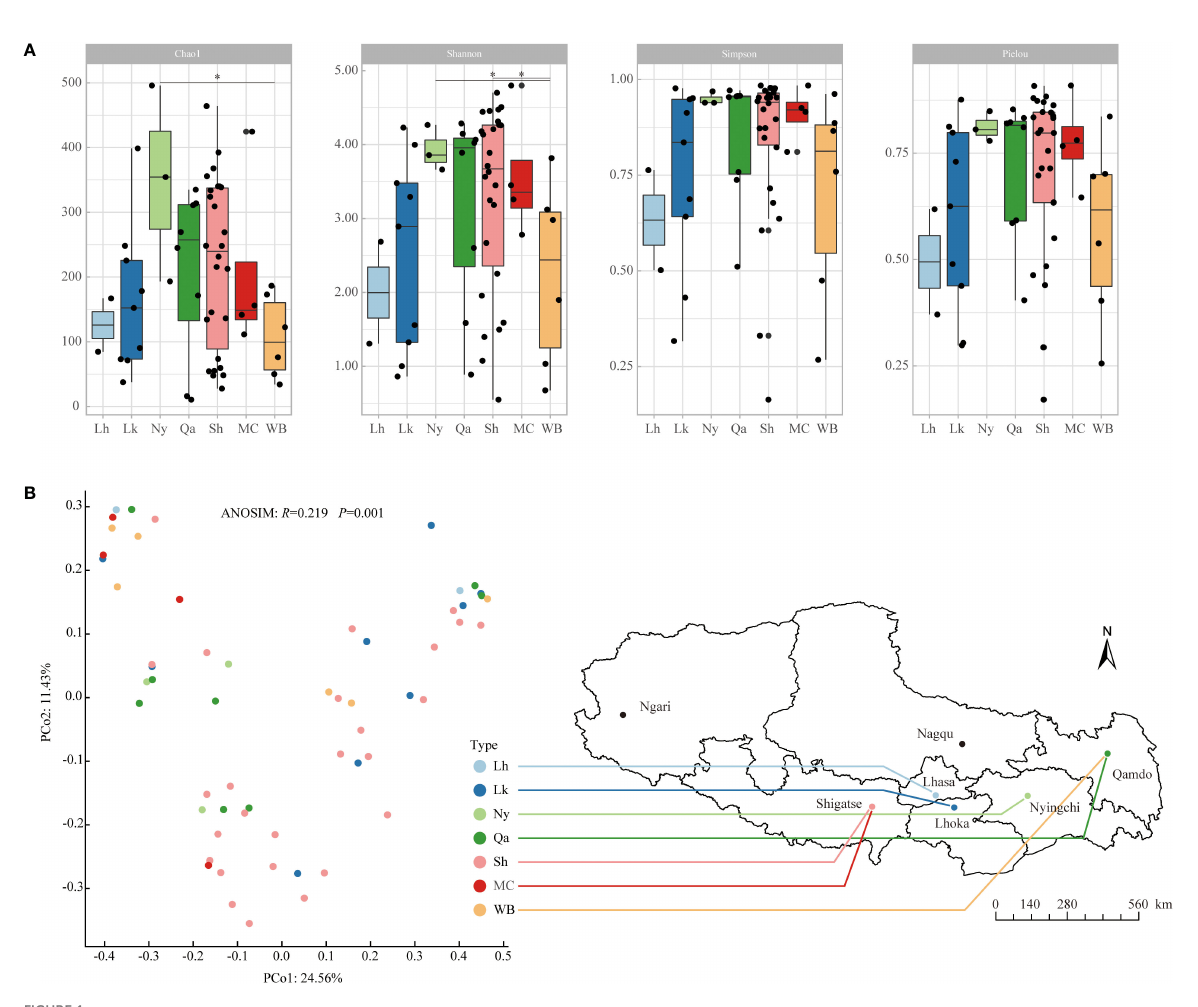
FIGURE 1 Alpha diversity and beta diversity of endophytic bacterial communities in different types of qingke seeds. (A) Alpha diversity. The “ * ” represent signi fi cant difference among different types of qingke seeds at 0.05 level. (B) Beta diversity was evaluated by PCoA ranking based on Bray-Curtis distance. Different colored dots represent different types of qingke seeds. Using ANOSIM analysis to assess the signi fi cance of differences in endophytic bacterial community structure in different types of qingke seeds. Lh, Lhasa landrace; Lk, Shannan landrace; Ny, Nyingchi landrace; Qa, Qamdo landrace; Sh, Shigatse landrace; MC, modern cultivars; WB, winter